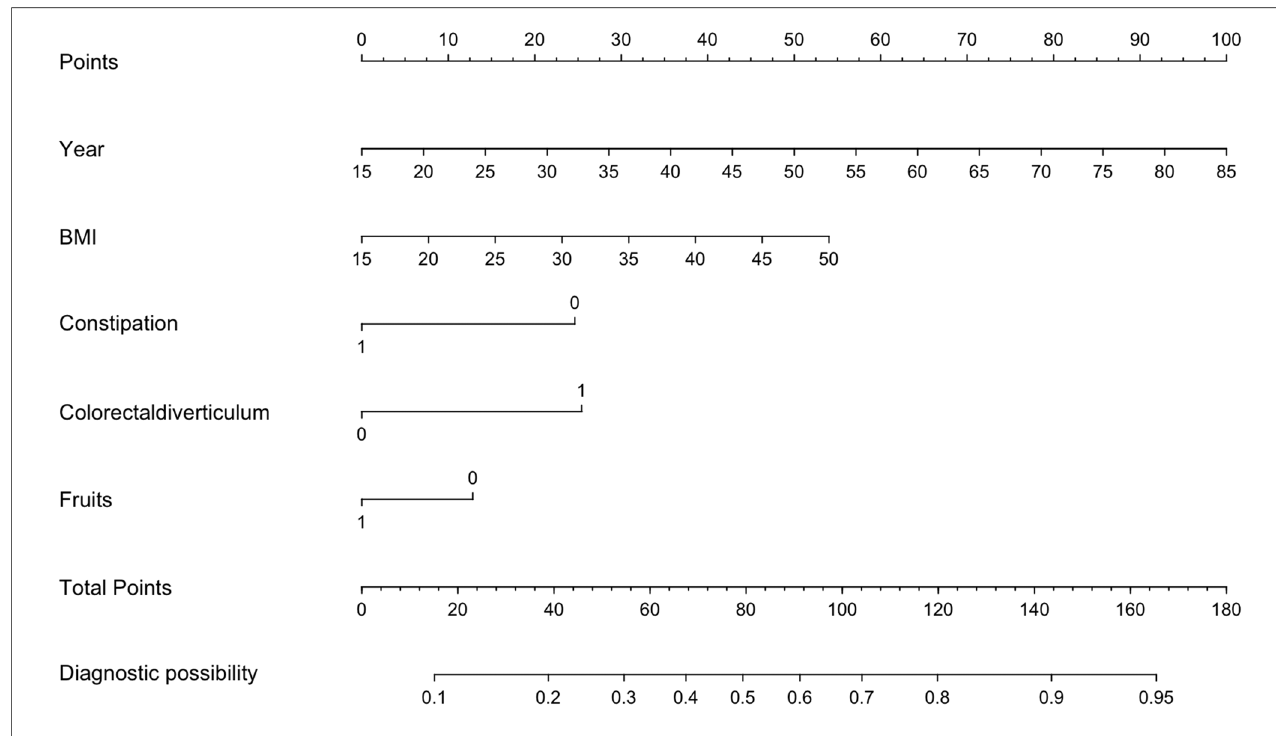
FIGURE 1 Nomogram predicting risk of colorectal polyps.